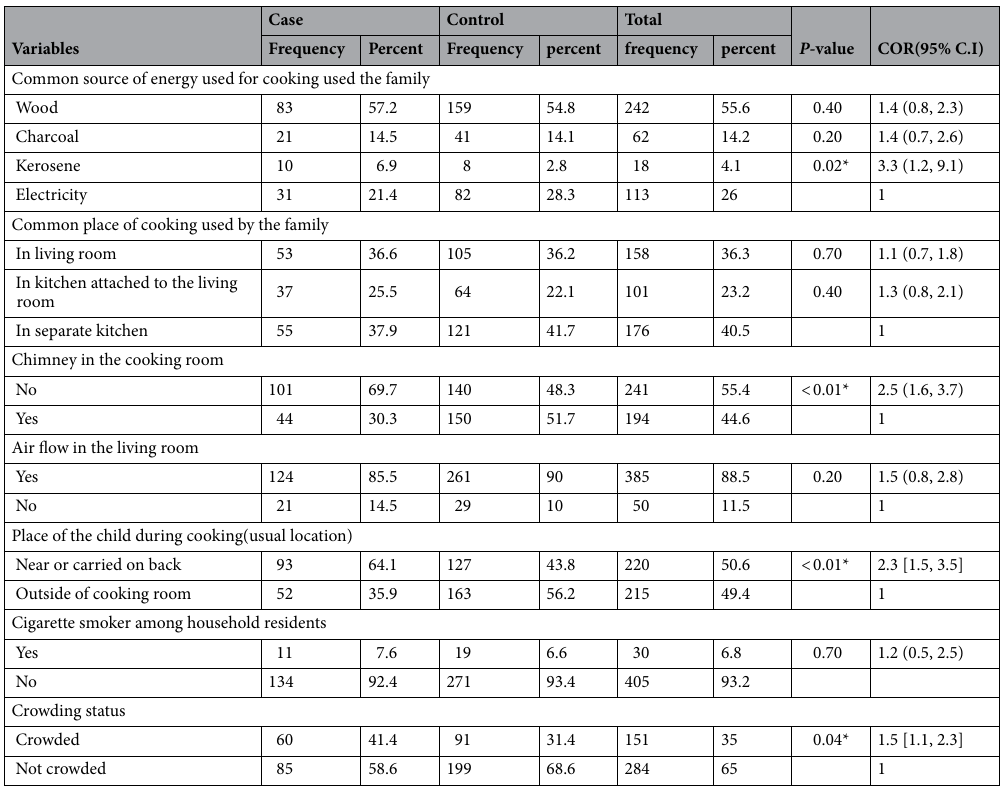
Table 3. Environmental characteristics of children aged 2–59 months attending public health facilities in Worabe town, Silte zone, 2017 (N = 145 cases and 290 controls). COR crude odds ratio, CI confidence interval, 1 reference